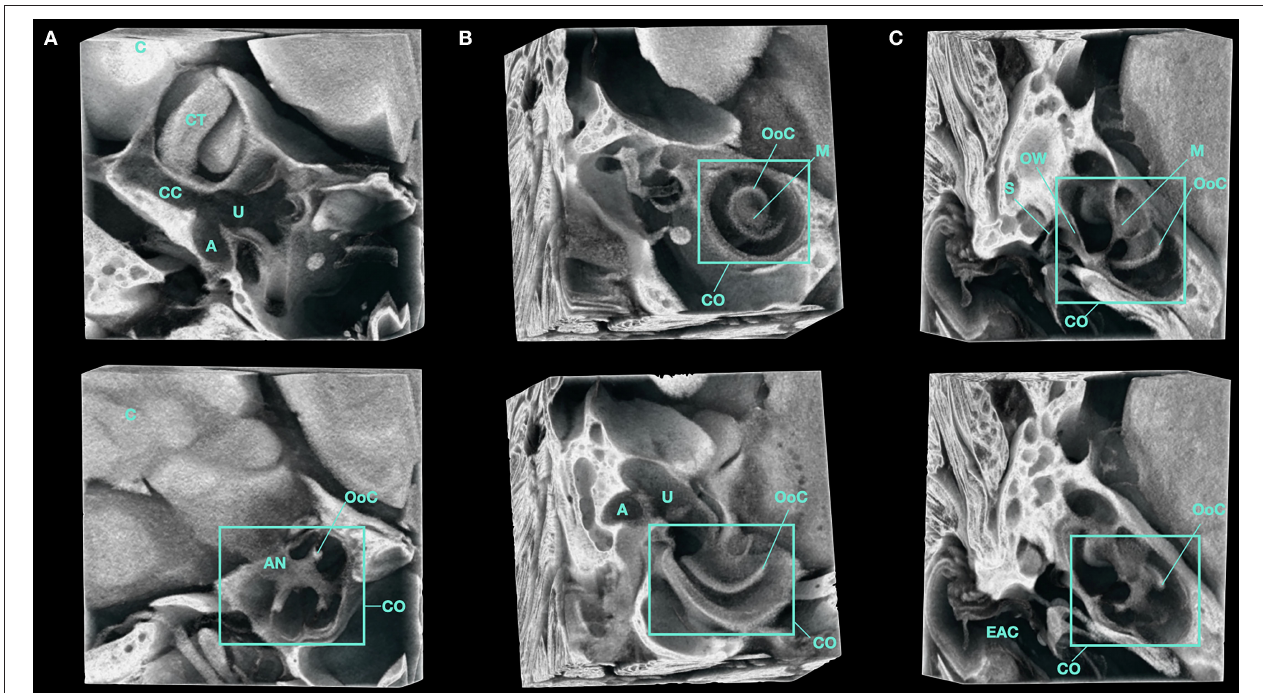
FIGURE 5 | 3D volume render of the inner ear of a Micro-CT imaged, PTA-immersed murine head. A representative volume of interest from the same sample is shown. (A–C) show orthogonal planes of the acquired data at various depths. A, Ampulla; AN, Auditory Nerve; C, Cerebellum; CT, Cerebellar Tonsil; CC, Common Crus; CO, Cochlea; EAC, External Auditory Canal; M, Modiolus; OoC, Organ of Corti; OW, Oval Window; S, Stapes; U,